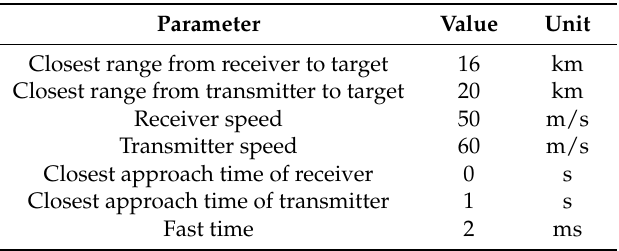
Table 1. Parameters for approximation error calculation.